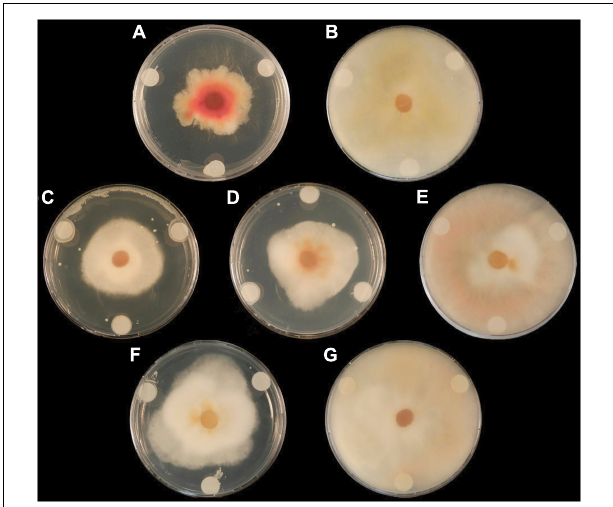
FIGURE 1 | The effect of lactic acid bacteria on radial growth of F. graminearum GZ3639 on potato dextrose agar plates at 7 days. Treatments (A) ( L. amylovorus FST 2.11), (C) ( L. brevis R2 (cid:49) ), and (D) ( L. amylovorus DSM 20053) displayed clear zones of fungal inhibition compared with the